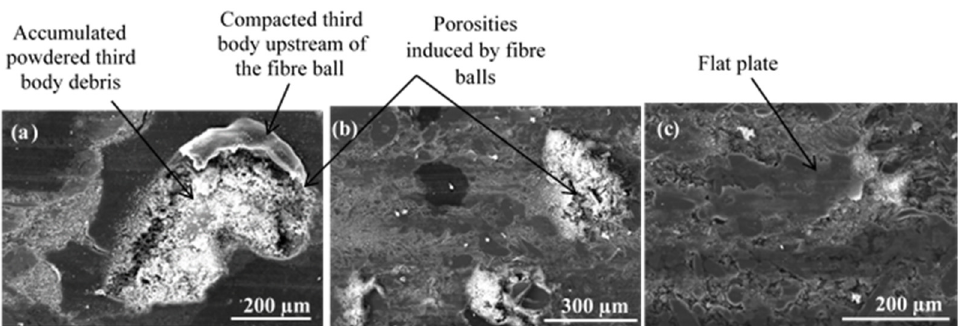
Figure 15. Load-bearing zone at IR (SEM, SE) with ( a , b ) porosities induced by fibre balls and ( c ) flat plates.